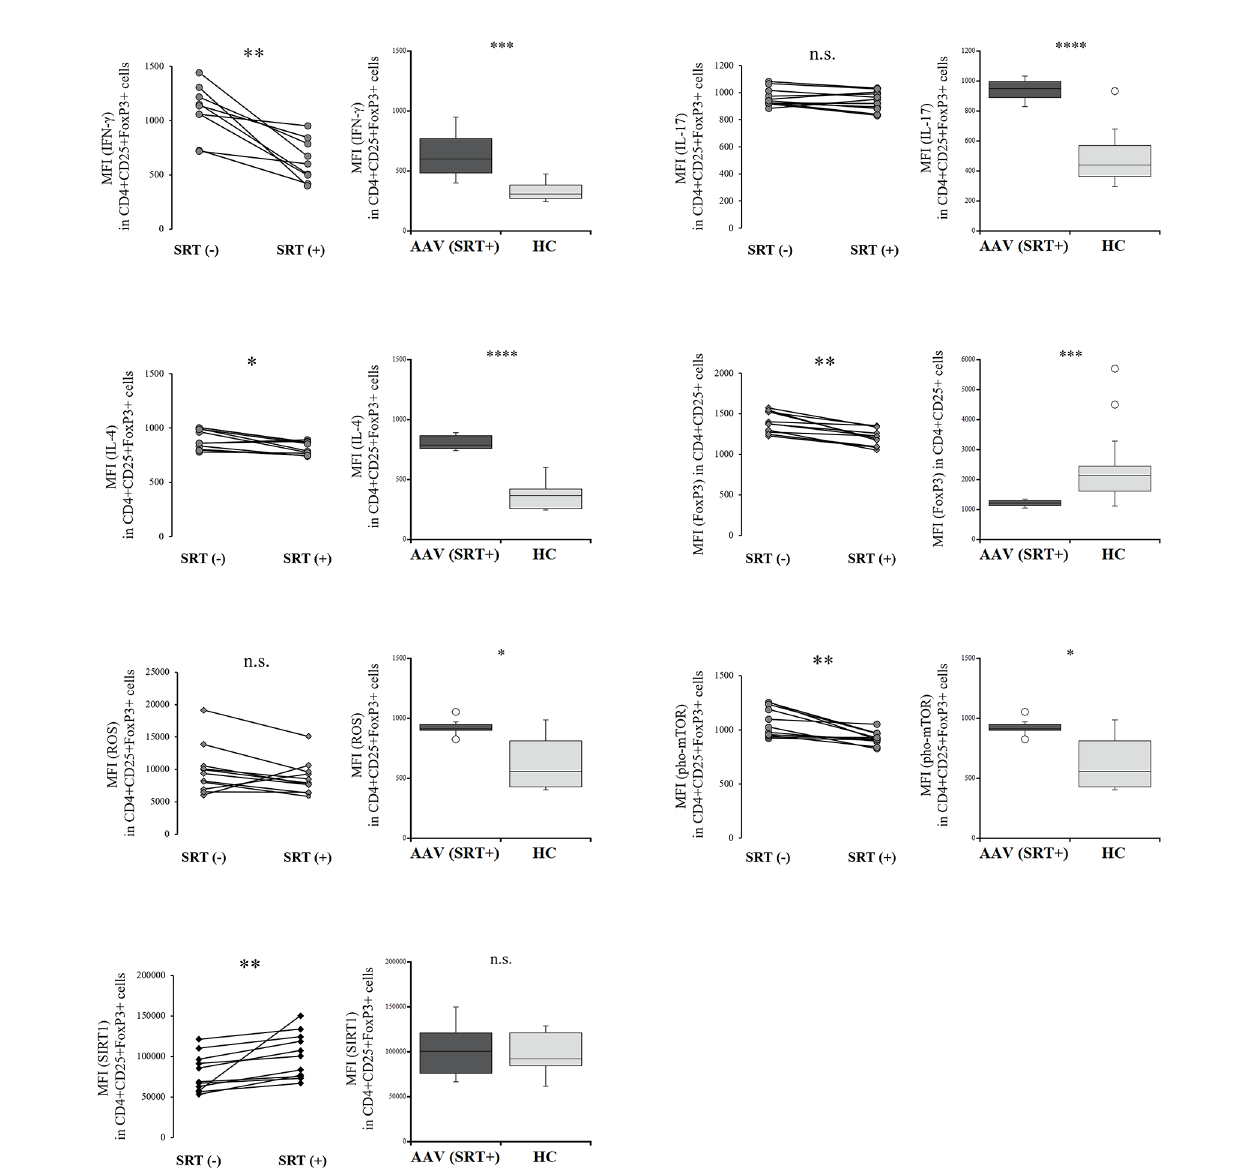
FIGURE 4 | Comparisons of regulatory T cells with and without SRT1720 treatment in the patients with AAV. Comparisons with and without SRT1720 treatment (left) and those between after SRT1720 treatment in the patients with AAV and healthy controls (HC) (right), with regards to median fl uorescence index (MFI) of interferon- g (IFN- g ), interleukin (IL)-17, or IL-4 in CD4+CD25+FoxP3+ cells (n = 11), MFI of FoxP3 in CD4+CD25+FoxP3+ cells (n = 11), MFI of ROS in CD4+CD25+FoxP3+ cells (n = 11), MFI of phosphorylated mammalian target of rapamycin (pho-mTOR) in CD4+CD25+FoxP3+ cells (n = 11), and MFI of sirtuin 1 (SIRT1) in CD4+CD25+FoxP3+ cells (n = 11). n.s., not signi fi cant; * p < 0.05; ** p < 0.005; *** p < 0.001; **** p <